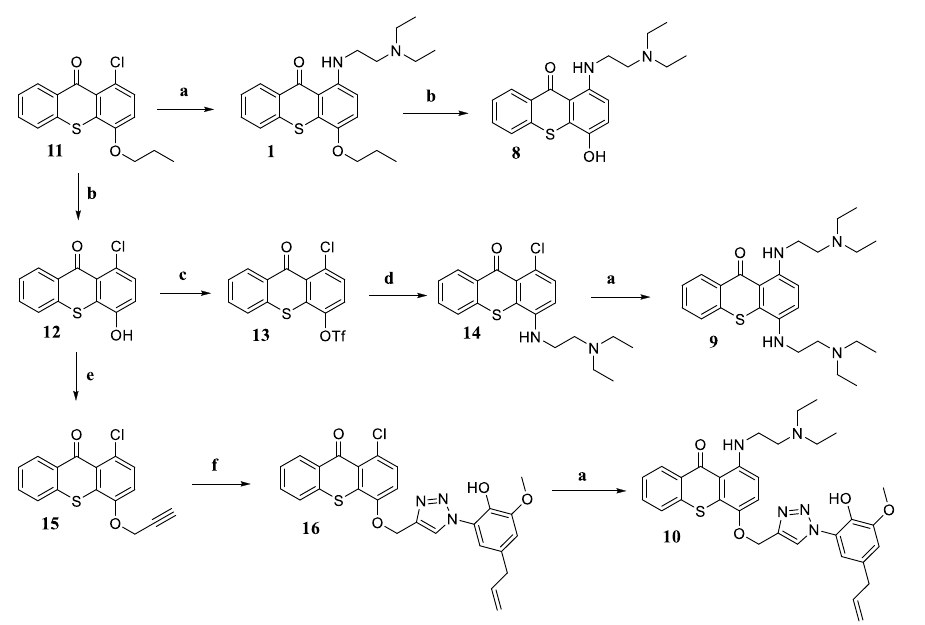
Scheme 1. Synthetic procedures of the new compounds 8 – 10 . Reagents and conditions ( a ) N , N